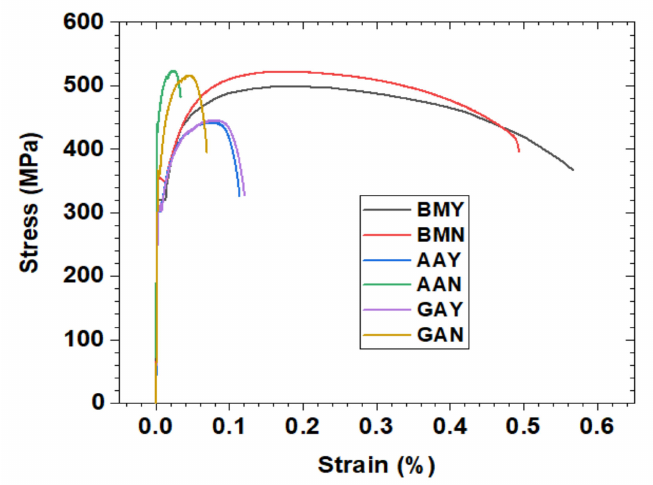
Figure 18. Tensile curves. BMY: parent, PWHT at 590 ◦ C; BMN: parent non PWHT; AAY: Butt weld, PWHT at 590 ◦ C; AAN: butt weld, non PWHT; GAY: butt weld, ground and PWHT at 590 ◦ C; GAN: butt weld, ground and non